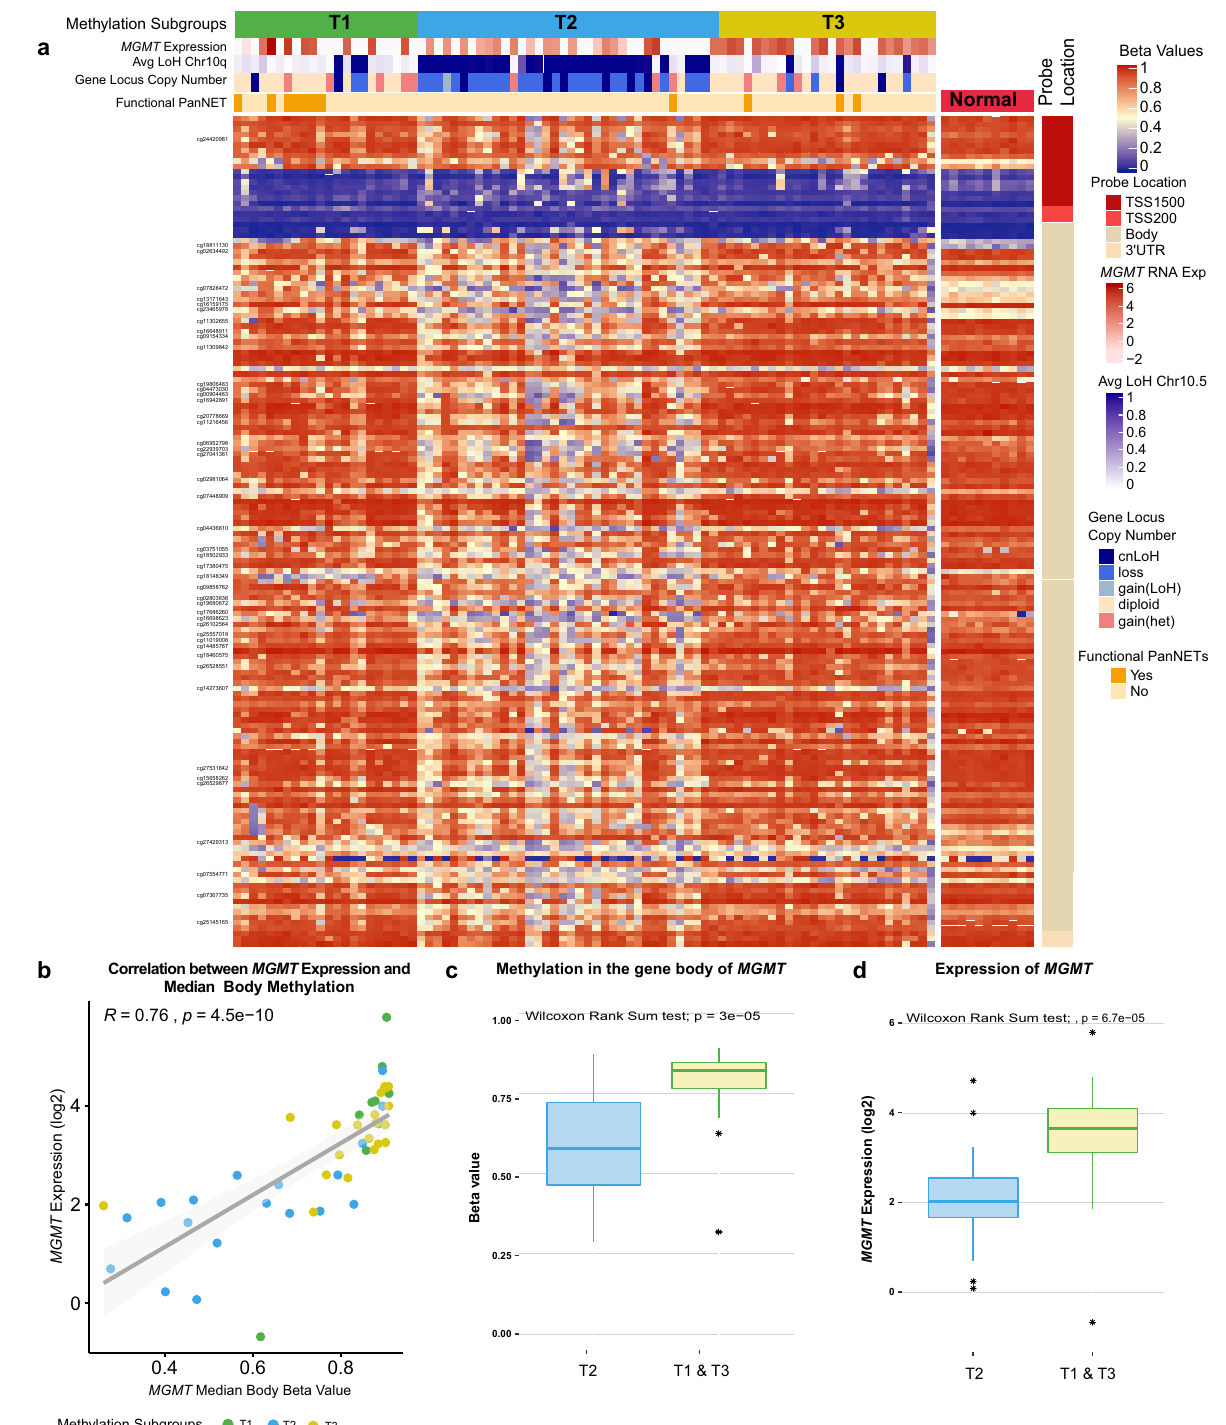
Fig. 3 Methylation levels of the MGMT gene. Tumour (columns) are presented in the same order as dichotomized clustering presented in Supplementary Fig. 1. a Heat map showing methylation levels across 156 CpG sites mapped to the MGMT gene, which passed the fi lters. Probes are plotted by genomic coordinates from 5 ′ to 3 ′ direction. Forty-six CpGs sites indicated on the left were differentially methylated between tumour subgroups and correlated with MGMT gene expression as assessed in 47 cases with RNASeq data. Levels of methylation in normal adjacent pancreata of CpG sites mapped to the MGMT gene is presented on the right. b Correlation of methylation median levels of 44 CpG sites located in the MGMT gene body and MGMT expression in the 47 cases with RNASeq data. c Average levels of methylation of MGMT gene body CpG sites for tumours in subgroup T2 ( n = 36) vs. subgroups T1 and T3 ( n = 48). d Gene expression levels of MGMT gene across 47 cases with RNASeq data (T2 n = 17, T1 and T3 n = 30). The box within the boxplots represents a range of values from the fi rst to third quantile and the line within represents the median value of the distribution. The whiskers represent the maximum and minimum values of the distribution excluding outliers and an asterisk represents any